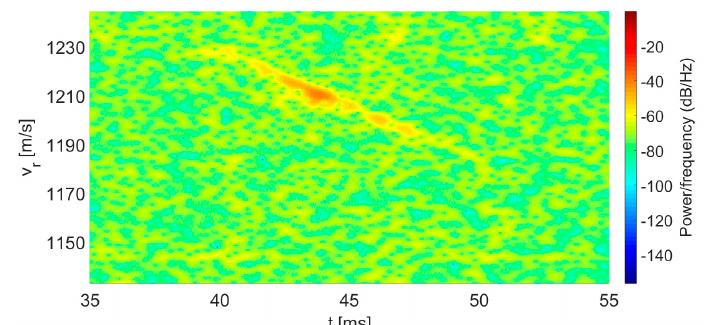
Figure 6. Spectrogram of the instantaneous bullet velocity vs. time.